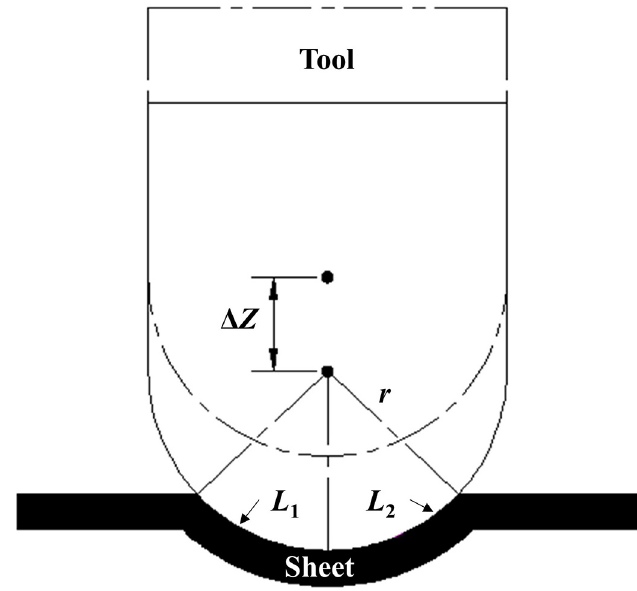
Fig. 5. Sketch of the initial contact